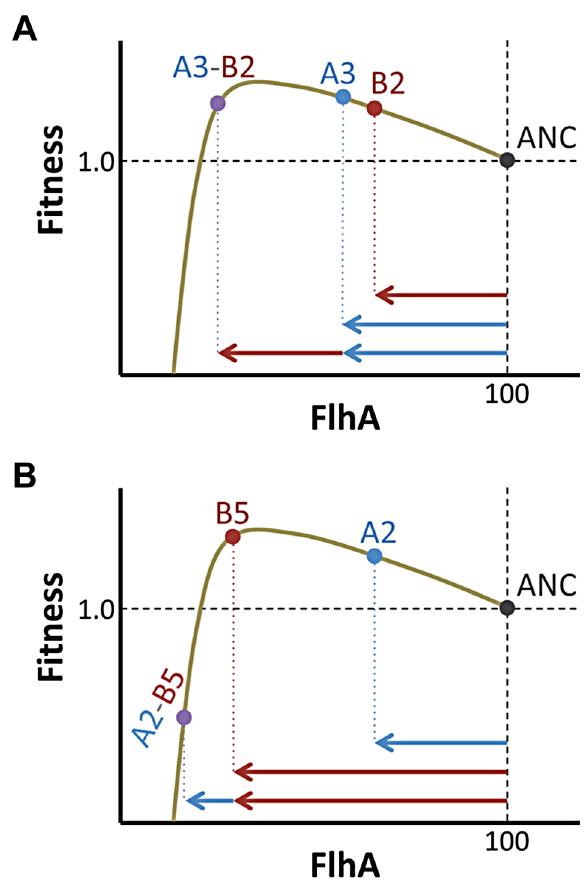
Figure 6. Phenotype and not just fitness value determines epistatic interactions. Mutations (A) A3 and (B) B5 had similar fitness values, but resided on opposite flanks of the optimal phenotype (shown here for simplicity as FlhA enzyme levels). In interactions with secondary beneficial mutations (B2 and A2, respectively), B5 fares worse due to being closer to the fitness cliff that occurs when FlhA catalysis becomes limiting.